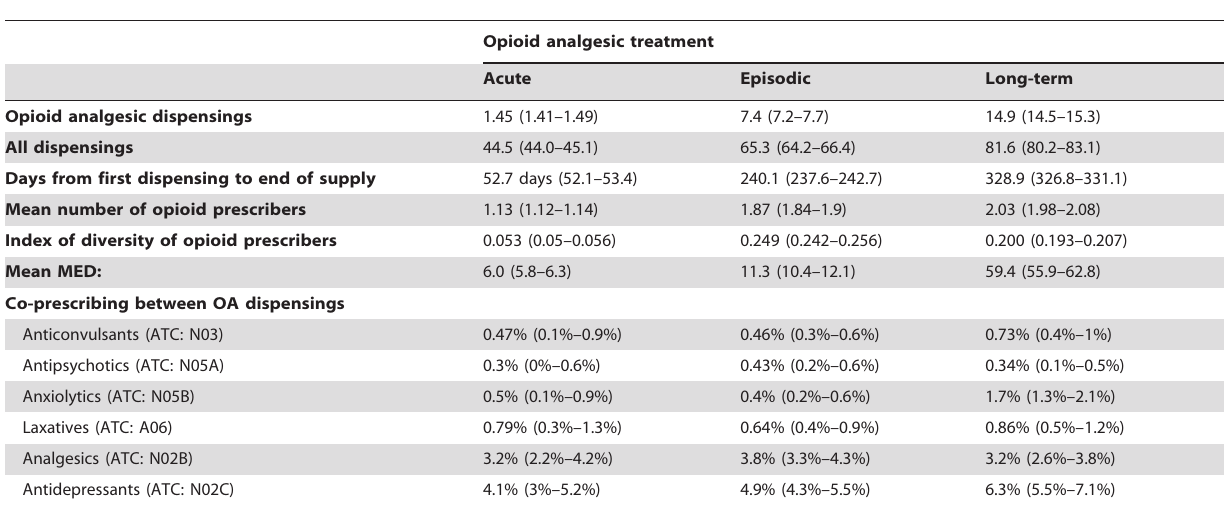
Table 2. Characteristics of opioid analgesic dispensings, including mean number, mean time of opioid supply, mean number of prescribers, mean index of diversity of opioid prescribers (higher index= more prescribers and more variance in number of dispensings per prescriber), mean oral morphine equivalents per day during period of opioid dispensings, and co-dispensing of other medicines during period of opioid supply by treatment group (see methods for details).